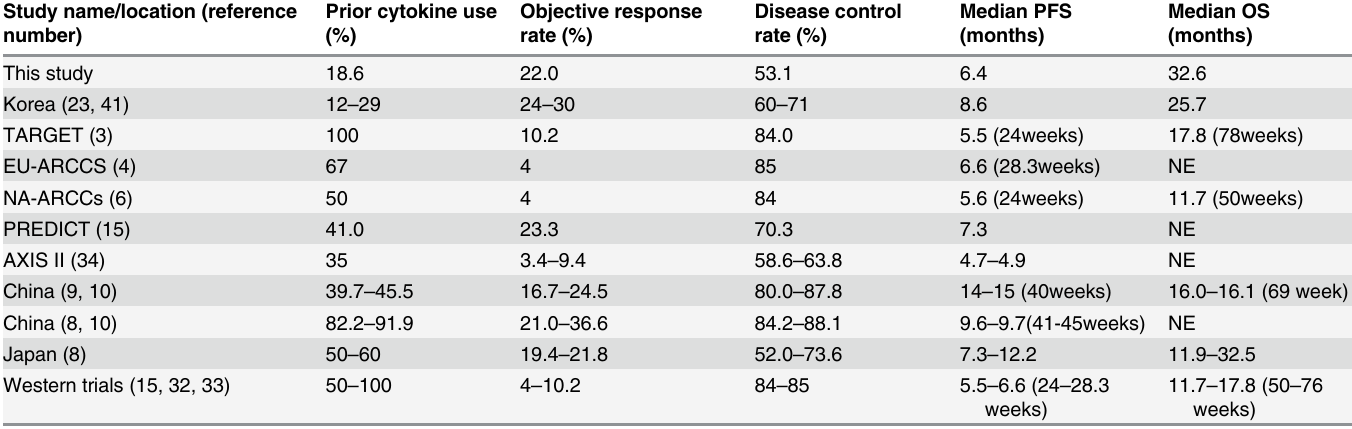
Table 4. Comparison of studies using sorafenib in advanced renal cell carcinoma from Korea and other nations, including Japan, China, and Western countries. Study name/location (reference